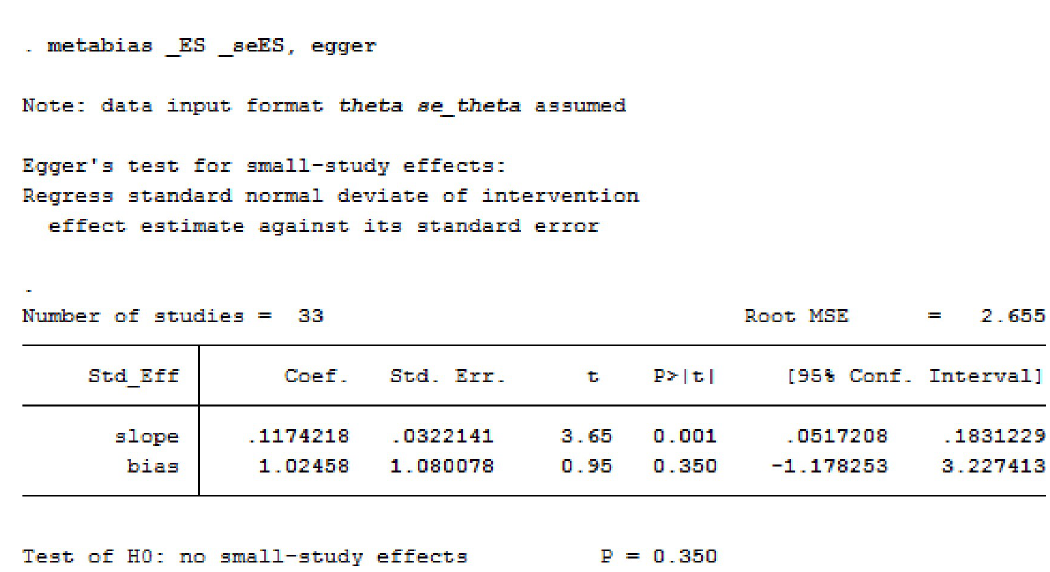
PLOS Global PublicHealth | https://doi.org/10.1371/journal.pgph.0000515 June 10, 2022 14 /